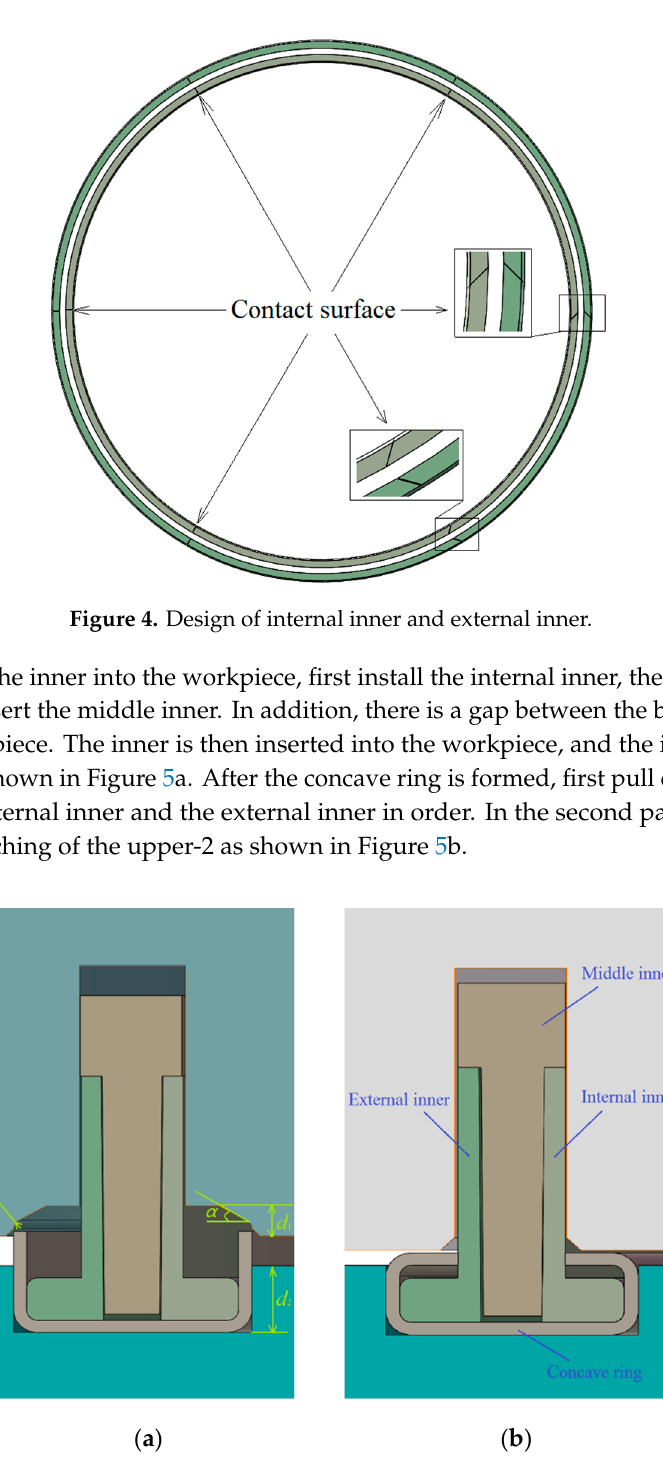
Figure 3. Exploded view of concave ring stamping die assembly. 1 — upper; 2—middle inner; 3— internal inner; 4—external inner; 5—blank; 6—lower.